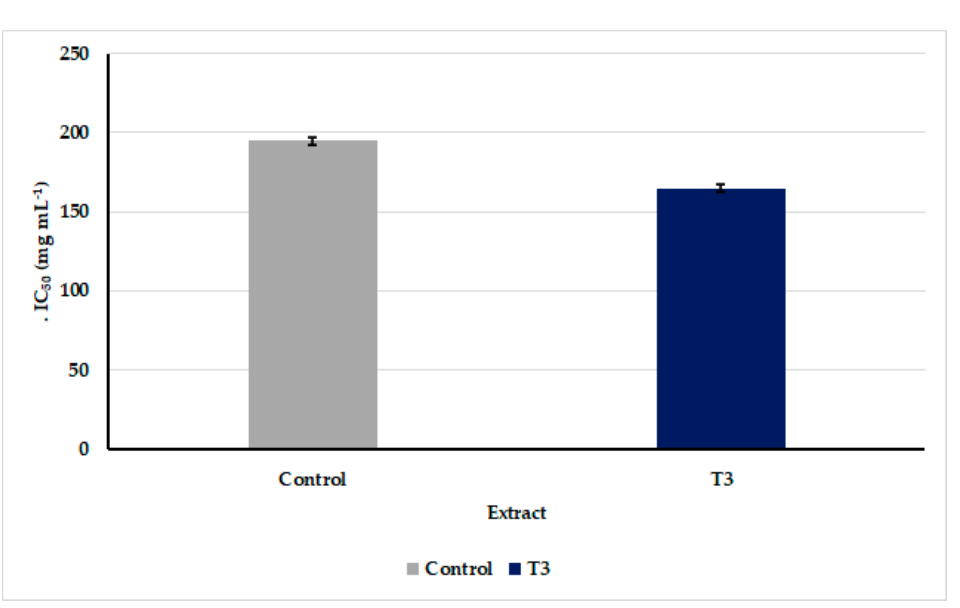
Figure 5. IC 50 of O. sancta crude extracts grown on standard Zarrouk’s medium (control) and modified Zarrouk’s medium concentration (T3).